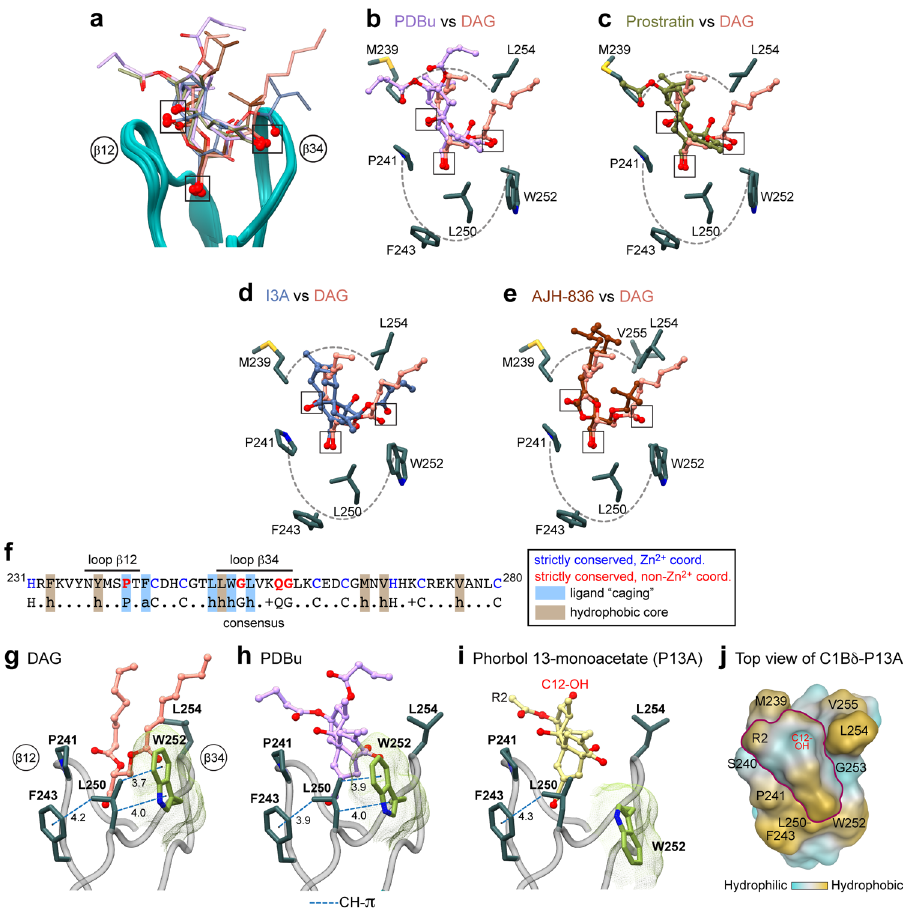
Fig. 6 Structural analysis of C1B δ -agonist complexes identi fi es three key oxygen-containing groups and the roles of conserved hydrophobic residues. a Loop region of the backbone-superimposed C1B δ complexes (pairwise r.m.s.d. <0.6 Å relative to chain 5 of the “ sn -1 ” DAG complex).